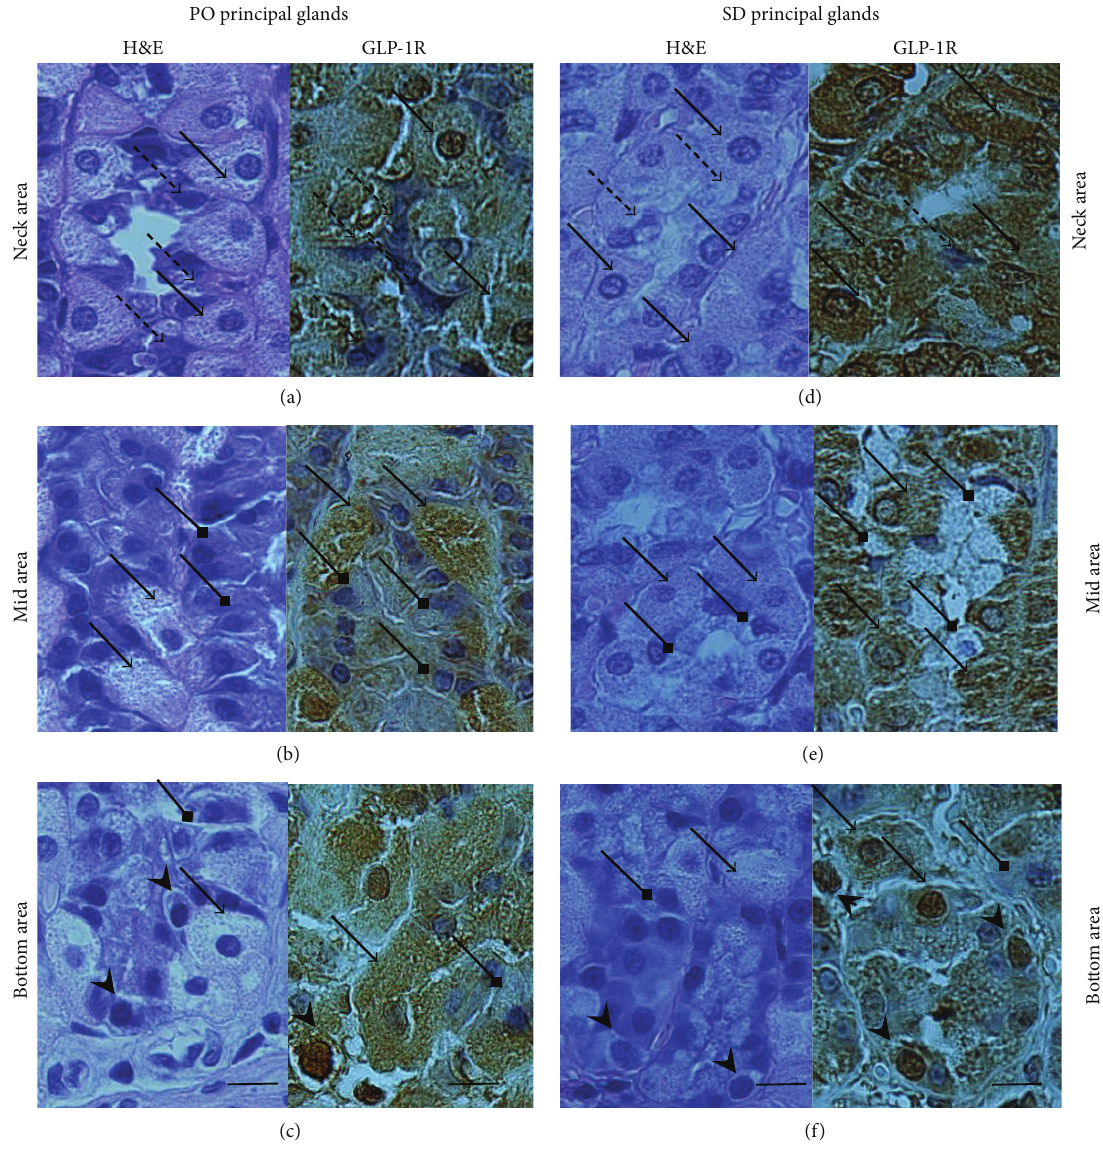
Figure 3: GLP-1R cellular association in gastric principal glands of PO and SPD rats. Longitudinal sections of gastric principal glands of PO (a, b, c) and SD rats (d, e, f). H&E staining (left panels) and GLP-1R immunostaining (right panels) are shown (magnification × 40). (a, d) Neck area of principal glands of PO (a) and SPD (d) rats is dominated by acid secreting parietal cells (solid arrows) which display strong GLP-1R immunoreactivity. Mucous secreting neck cells (broken arrows) demonstrate no GLP-1R immunoreactivity. (b, e) Mid area of principal glands of PO (b) and SPD (e) rats is populated by acid secreting GLP-1R immunostained parietal cells (solid arrows) and chief cells without GLP-1R immunoreactivity (square head arrows). (c, f) Bottom area of principal glands of PO (c) and SPD (f) rats. GLP-1R immunopositive enteroendocrine-like cells (head only arrows), parietal cells (solid arrows), and chief cells (square head arrows) without GLP-1R immunoreactivity are shown. Bar = 20 𝜇